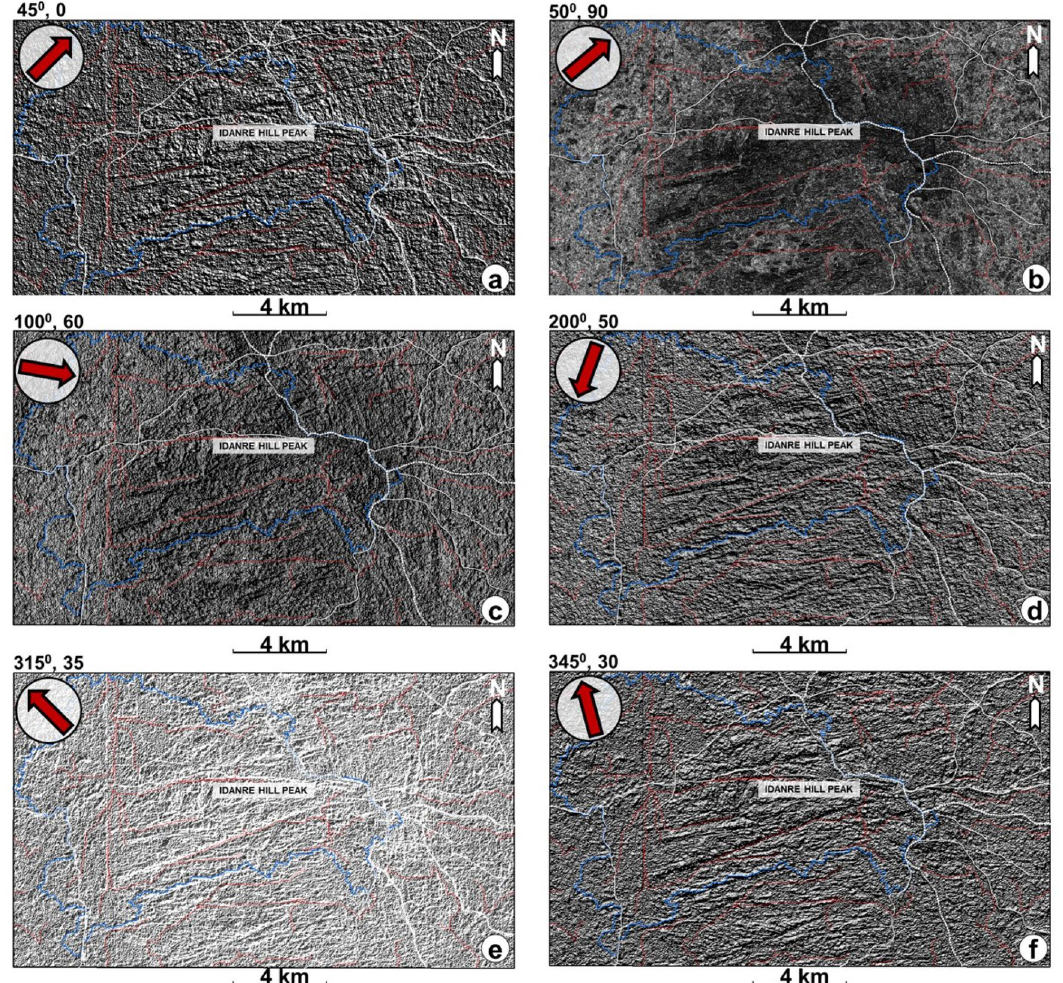
Figure 5. Multi-directional hillshade maps overlain by stream network (red lines) and watershed (blue lines) of the study area. The hillshade maps are generated from google earth digital surface model (DSM) using different azimuth angles shown by the inset red arrows. ( a ) 45° azimuth ( b ) 50° azimuth ( c ) 100° azimuth angle ( d ) 200° azimuth angle ( e ) 315° azimuth and ( f ) 345°